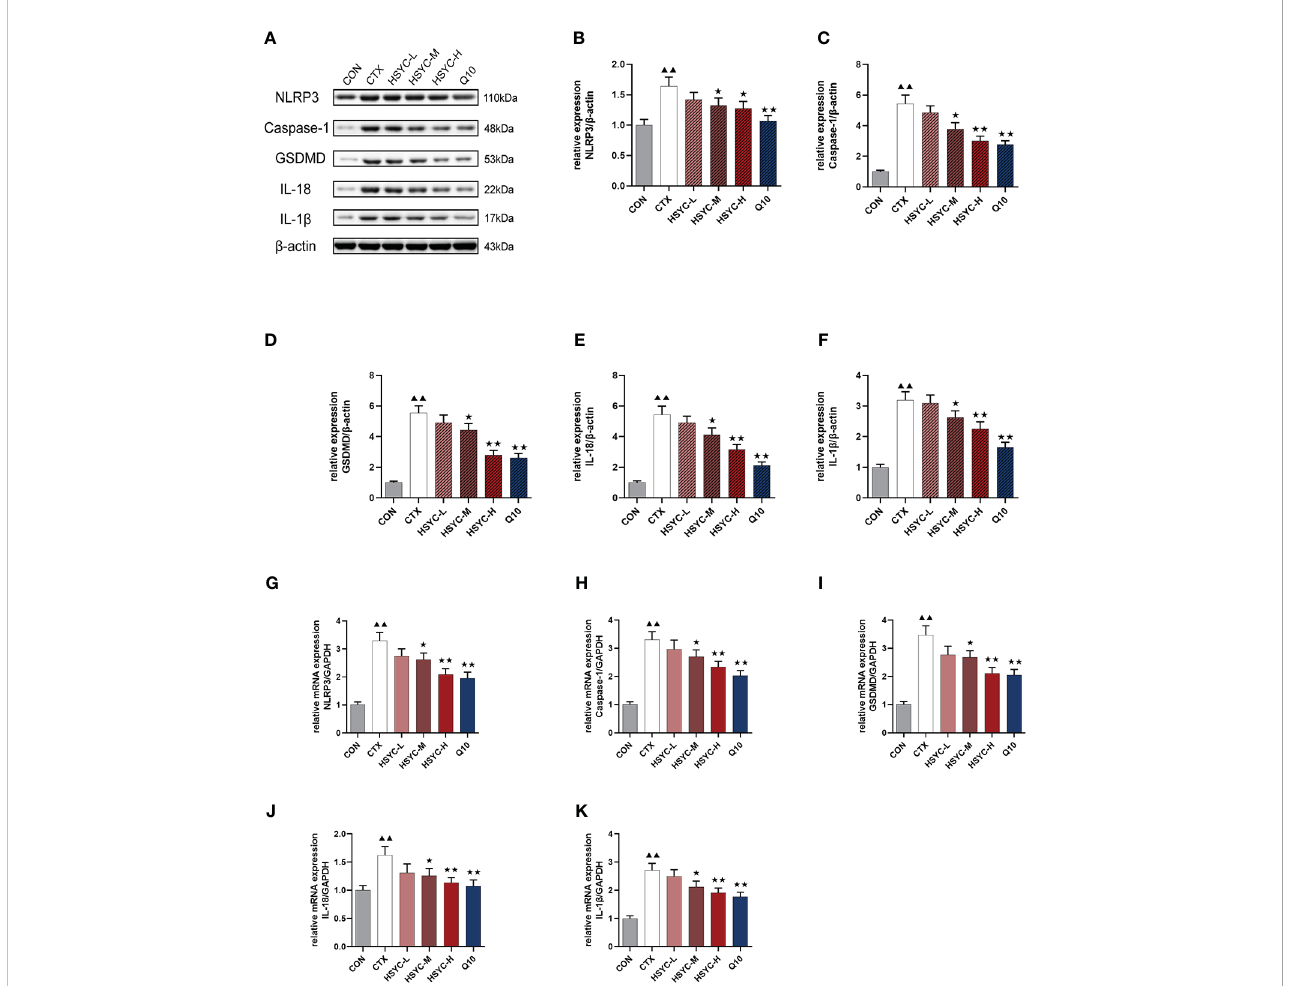
FIGURE 7 Effect of HSYC on the expression of NLRP3 in fl ammasomes-associated genes and proteins. (A-F) Effect on NLRP3, Caspase-1, GSDMD, IL-18, and IL-1 b proteins in the granulosa cells of different groups. (G-K) Effect NLRP3, Caspase-1, GSDMD, IL-18, and IL-1 b mRNAs in the granulosa cells of different groups. Histogram elements represent the mean ± SD (n=3). ▲▲ presents P < 0.01 compared to the CON group; ★ presents P < 0.05 compared to the CTX group; ★★ presents P < 0.01 compared to the CTX